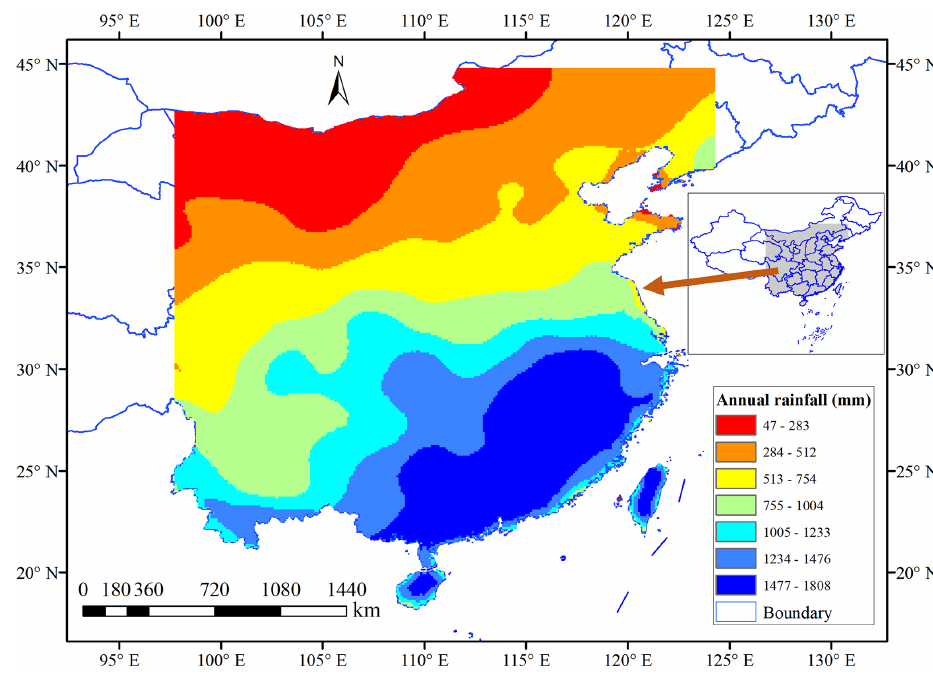
Figure 1. The study area for short-term precipitation